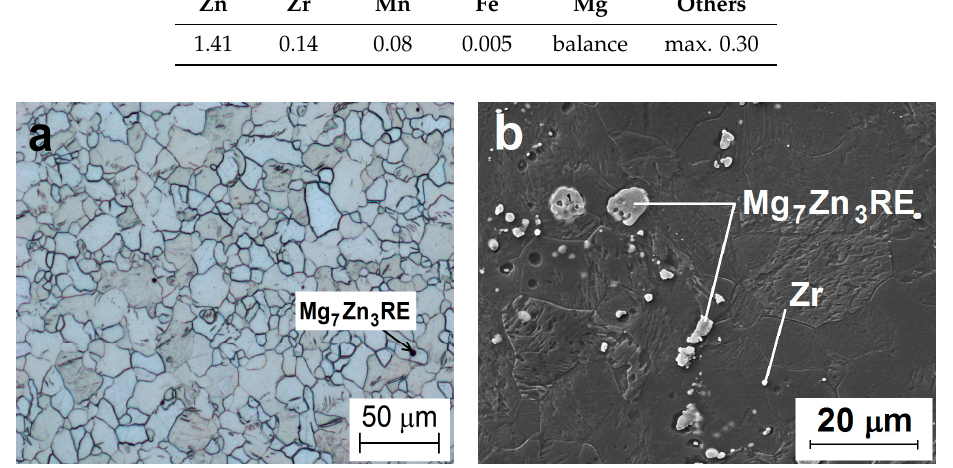
Figure 1. Surface microstructure of the ZE10 wrought magnesium alloy: ( a ) microstructure (LM); ( b ) intermetallic phase particles in microstructure (SEM).